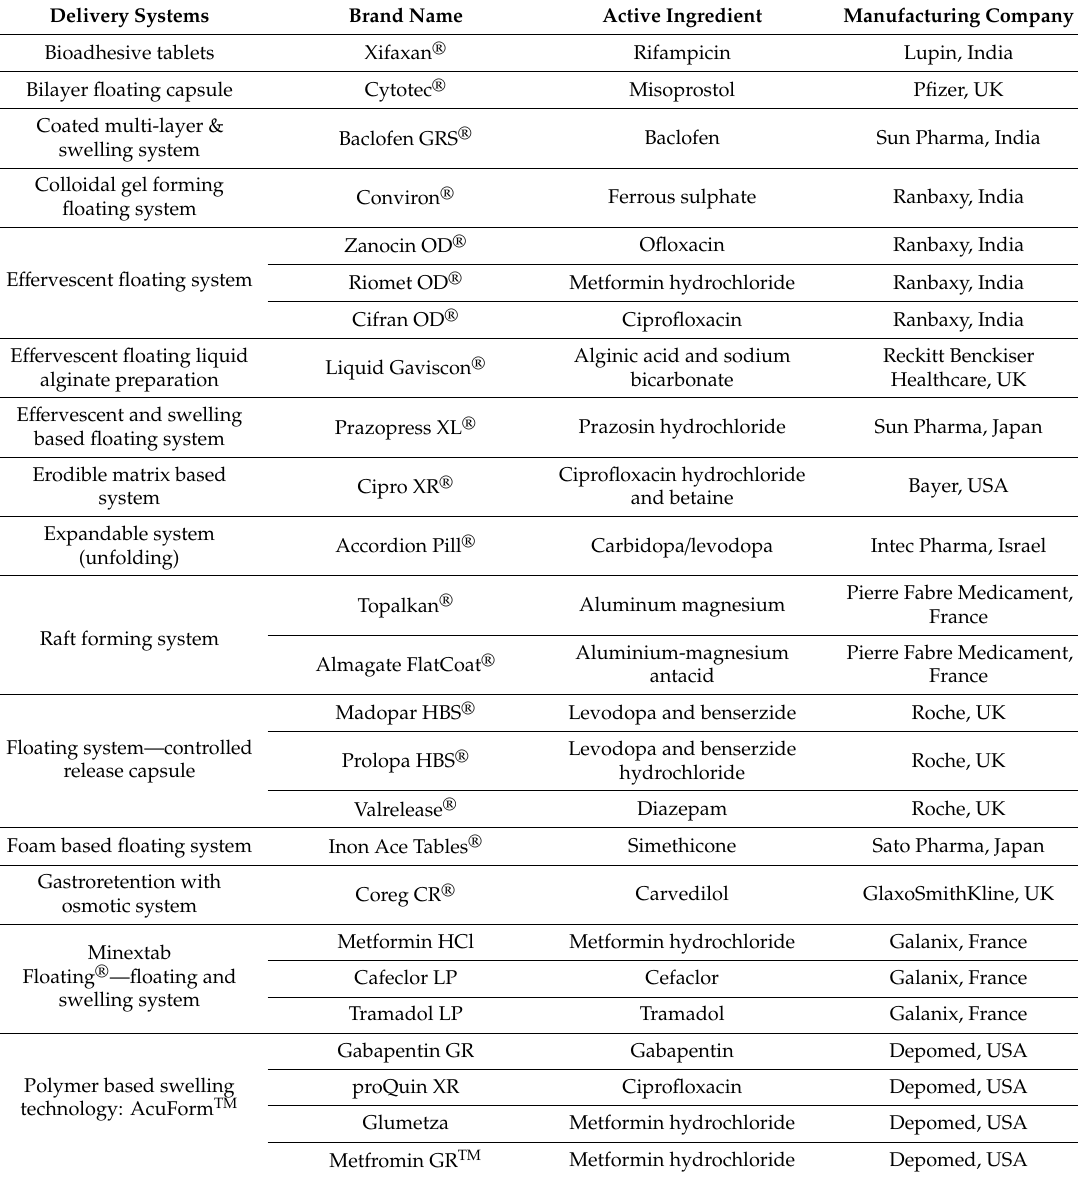
Table 3. Various gastroretentive products available in the market